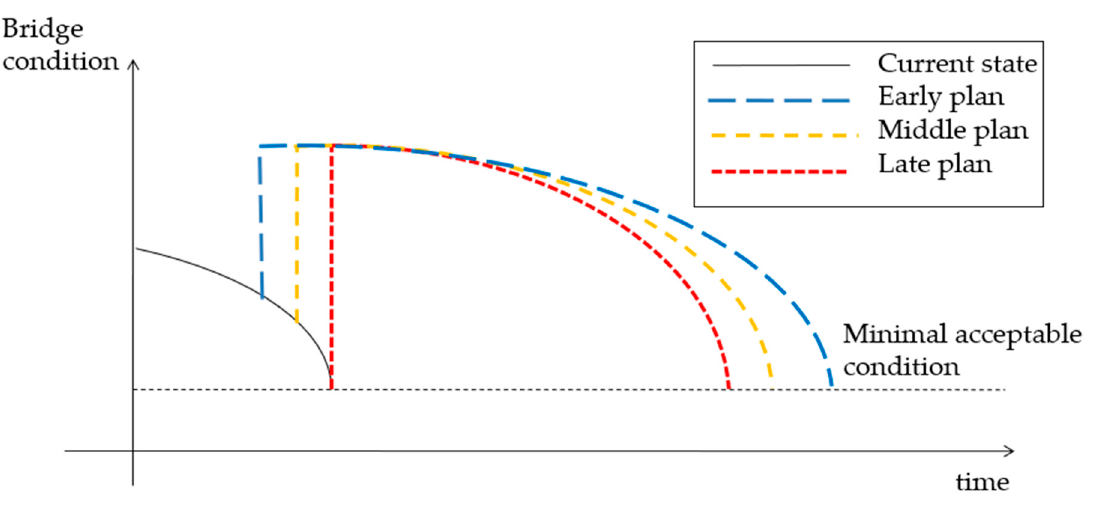
Figure 2. Diagram of different plans.